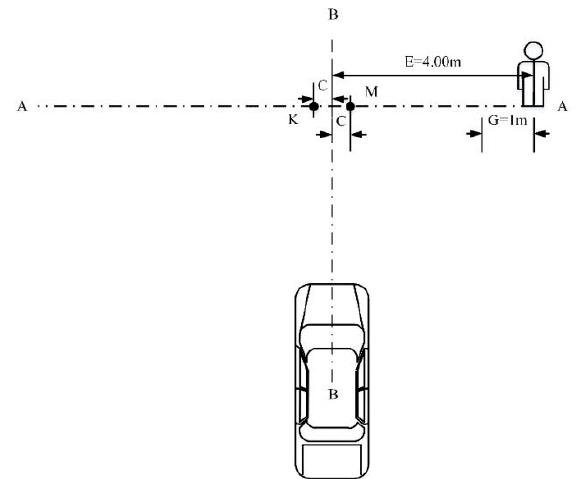
Figure 20. The PID lower controller model.